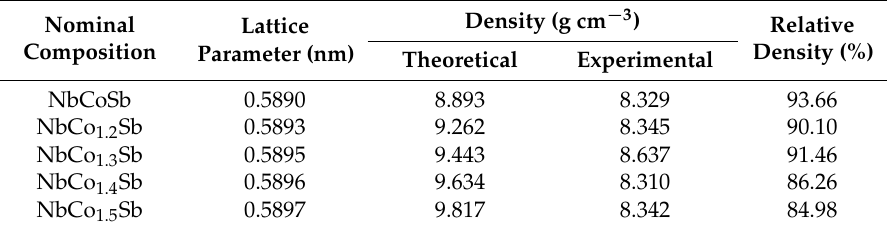
Table 1. Lattice parameter, theoretical, experimental, and relative density of NbCo 1+ x Sb ( x = 0, 0.2, 0.3, 0.4, 0.5) samples.